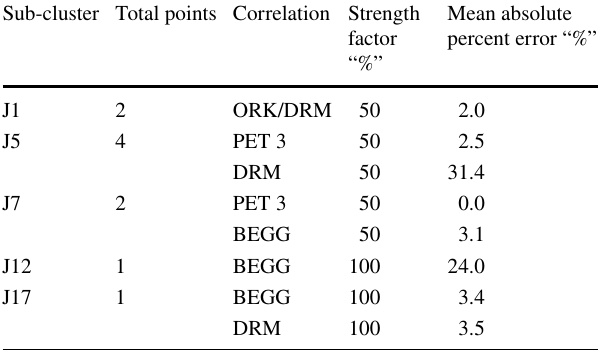
Table 18 Best correlations for cluster (J) Sub-cluster Total points Correlation Strength